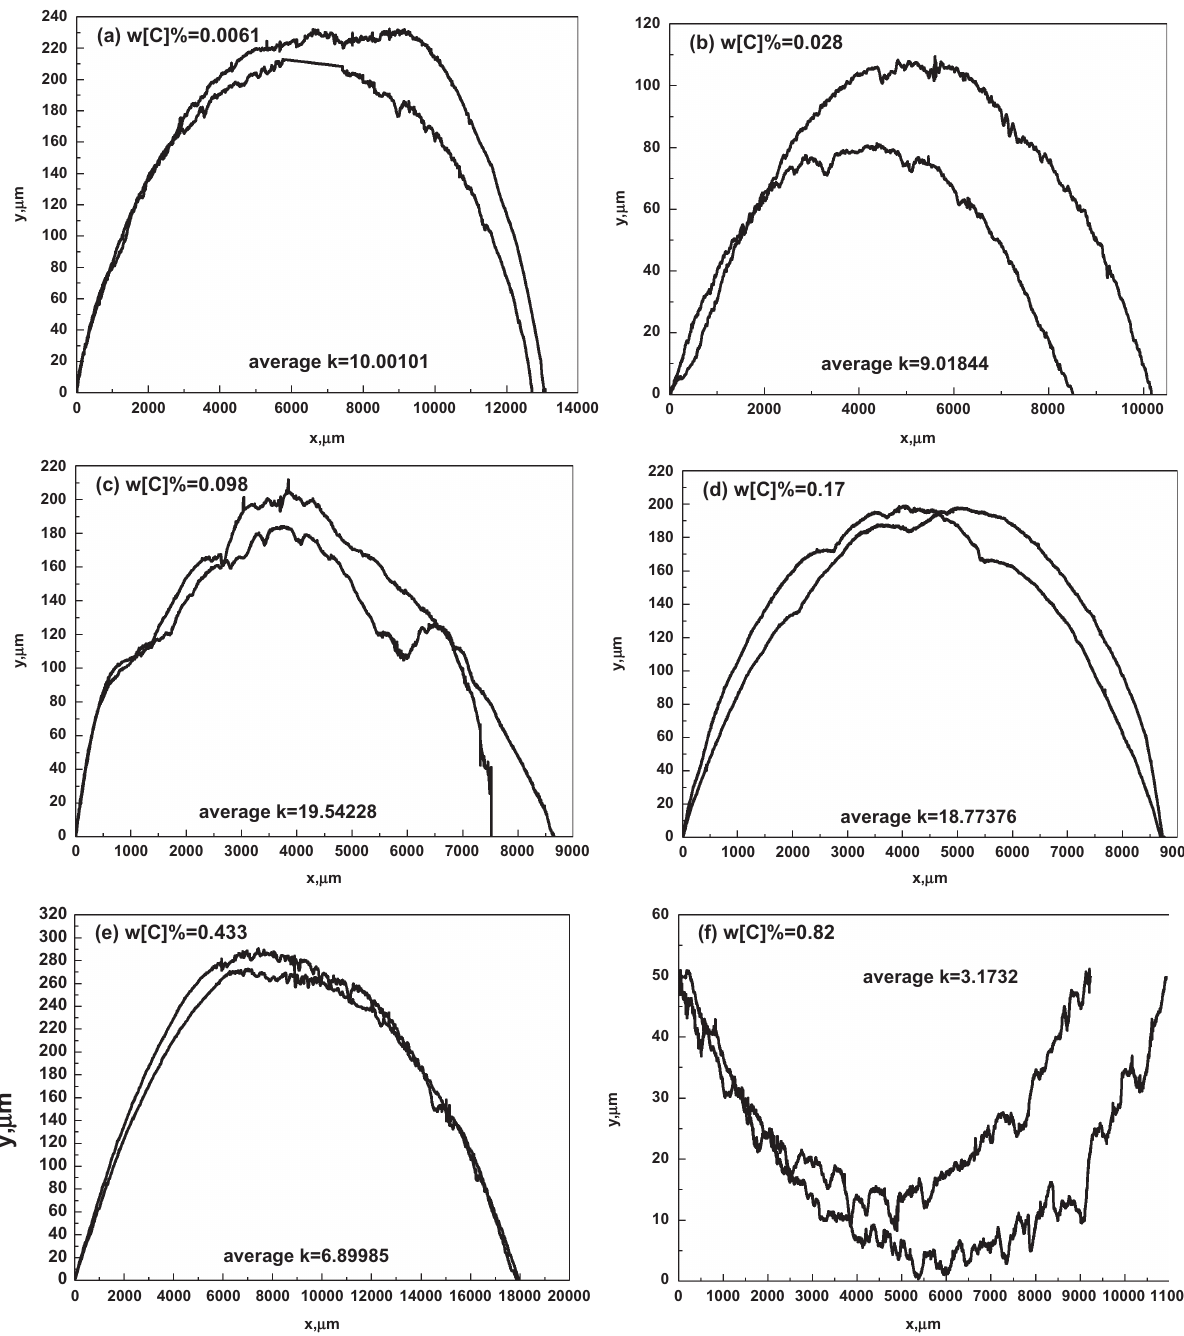
Figure 11: The bottom profiles of center section of solidified shell with different carbon content, (a)ultra-low carbon steel; (b) low carbon steel; (c) hypo-peritectic steel; (d) peritectic steel; (e) hyper-peritectic steel; (f) high carbon